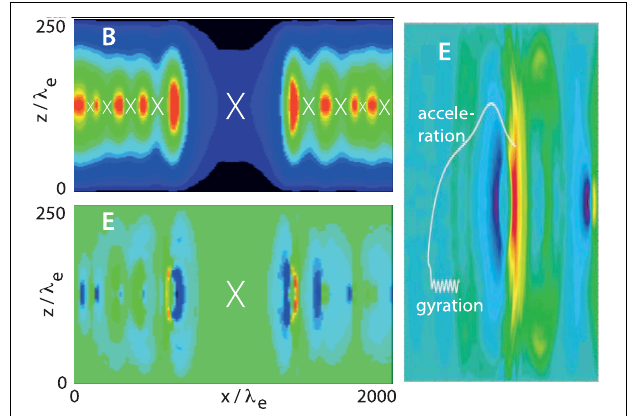
FIGURE 5 | Three-dimensional simulation of non-Hall reconnection in a pair plasma of high resolution in a large domain simulation data taken from Jaroschek et al. [42]. Top: Magnetic flux in color representation (only relative scales are given here). Contours indicate the magnetic topology. Several X point are generated separated by plasmoids (red blobs), indicating evolution of a tearing mode. The initial reconnection region dominates all secondary X points. These have their own dynamics. Note that the horizontal extension (length of the diffusion region) is several times its vertical extension indicating jetting. Bottom: Electric fields (red is positive, blue negative). Strong fields evolve around the plasmoids causing electron-positron acceleration. Plasma jetting occurs around each X point thus leads to competition, jet braking and deviation. In this 3-dimensional simulation the X points have finite extension perpendicular to the plane shown. Right: Orbit of one selected accelerated electron in the electric field near the first right plasmoid. Originally the electron performs a meandering oscillatory gyration in the current sheet between the two opposing magnetic fields until feeling the reconnection electric field, picking up energy and enlarging its gyroradius. At the end of the orbit shown it just enters the strong field on the backside of the plasmoid to become further